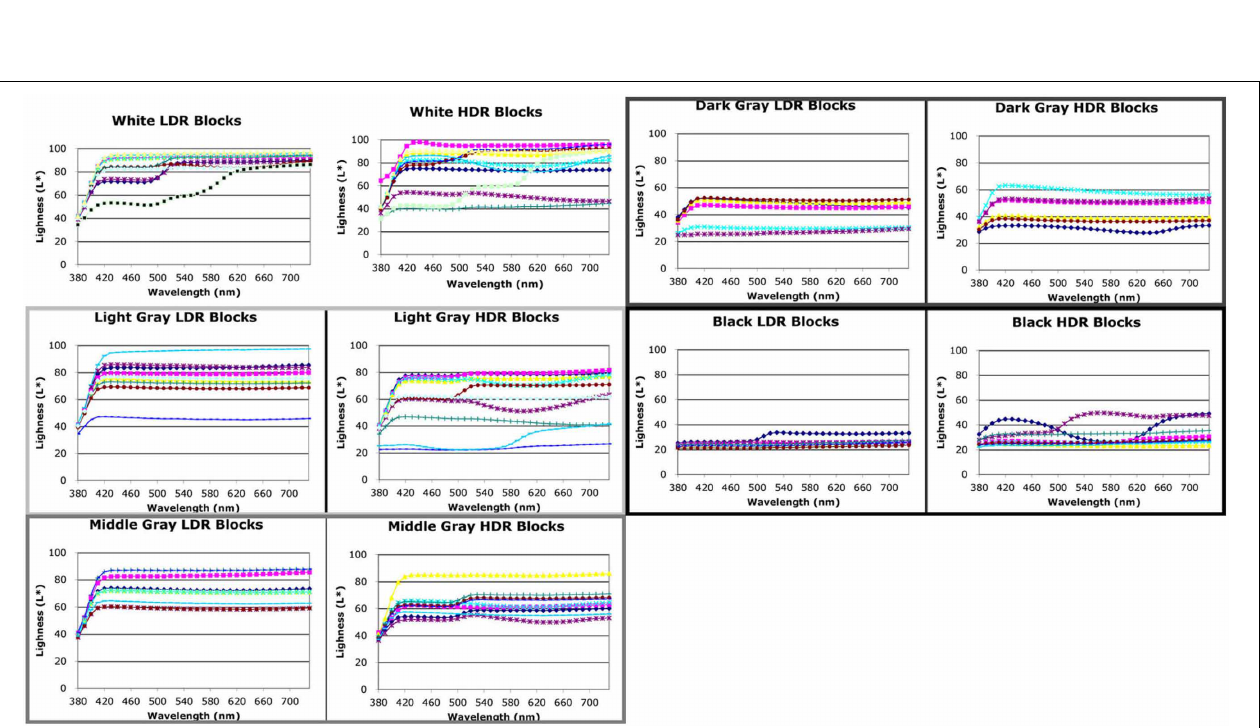
FIGURE 9 | Reflectance spectra scaled by L ∗ of white, grays, and black facets measured from watercolor LDR and HDR paintings.